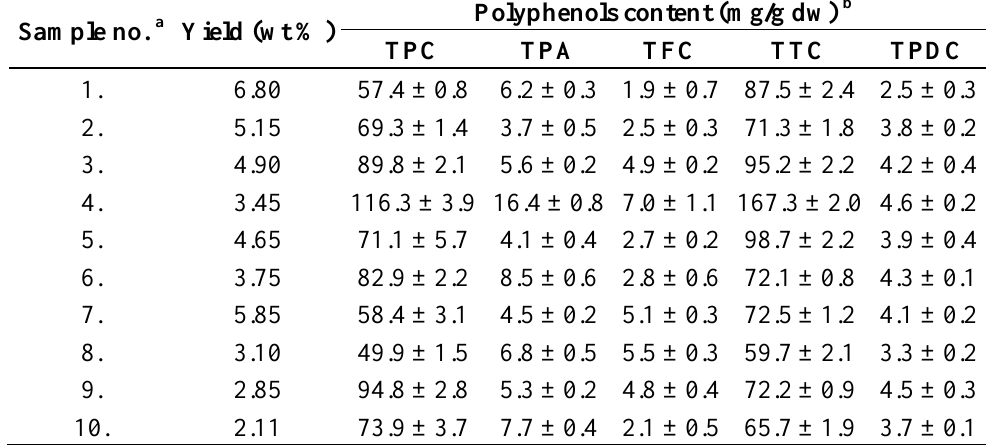
Table 2. Extraction yield, total phenolic (TPC), total phenolic acids (TPA), total flavonoids (TFC), total tannins (TTC) and total proanthocyanidins (TPDC) content of Potentilla